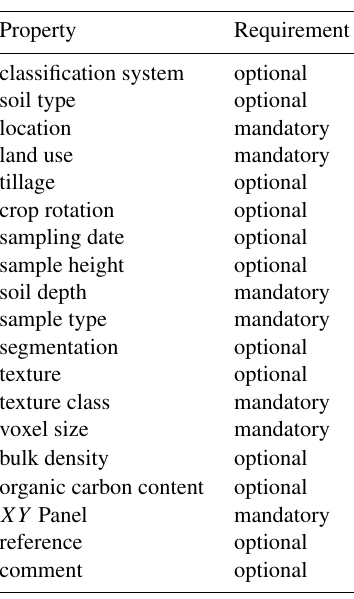
Table 1. Summary of meta information.